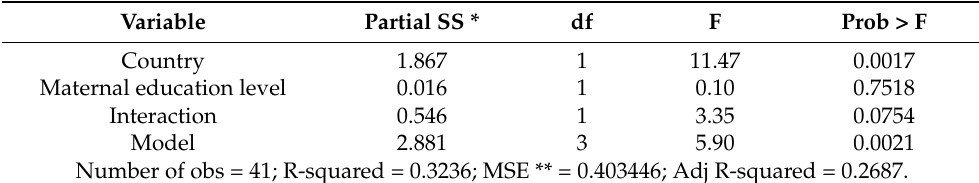
Table 8. Country and maternal education-level estimates.